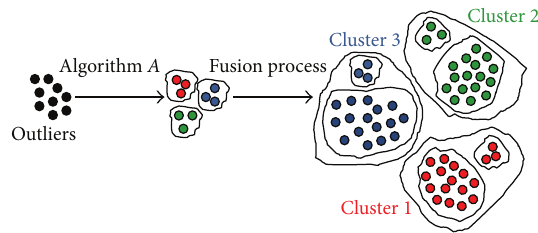
Figure 4: Step 2 of ASClass i